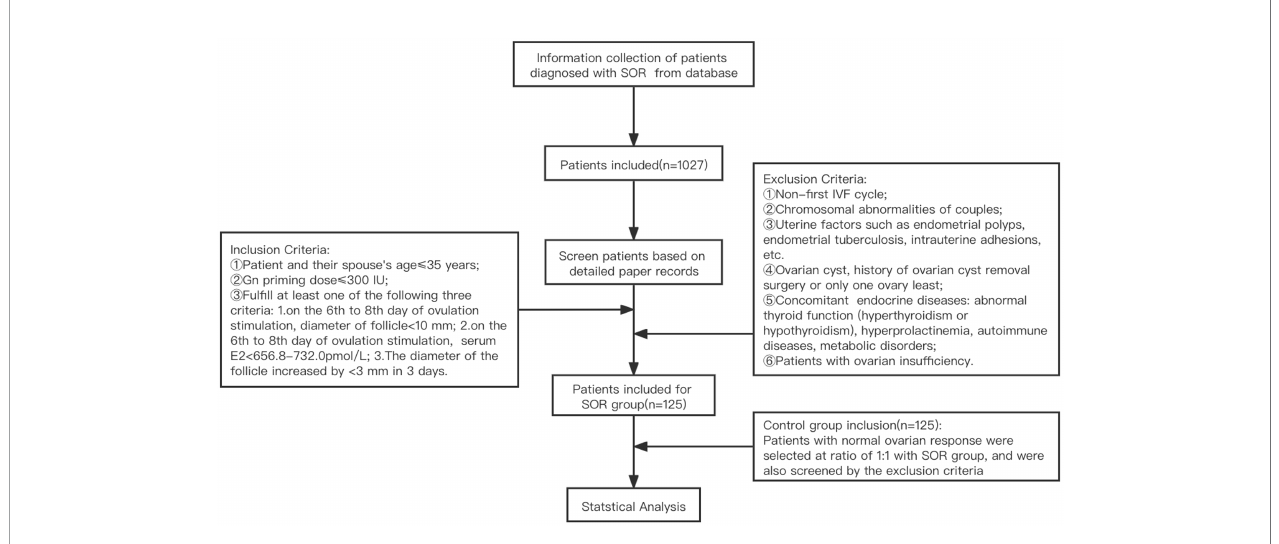
FIGURE 2 | Process of the Patients